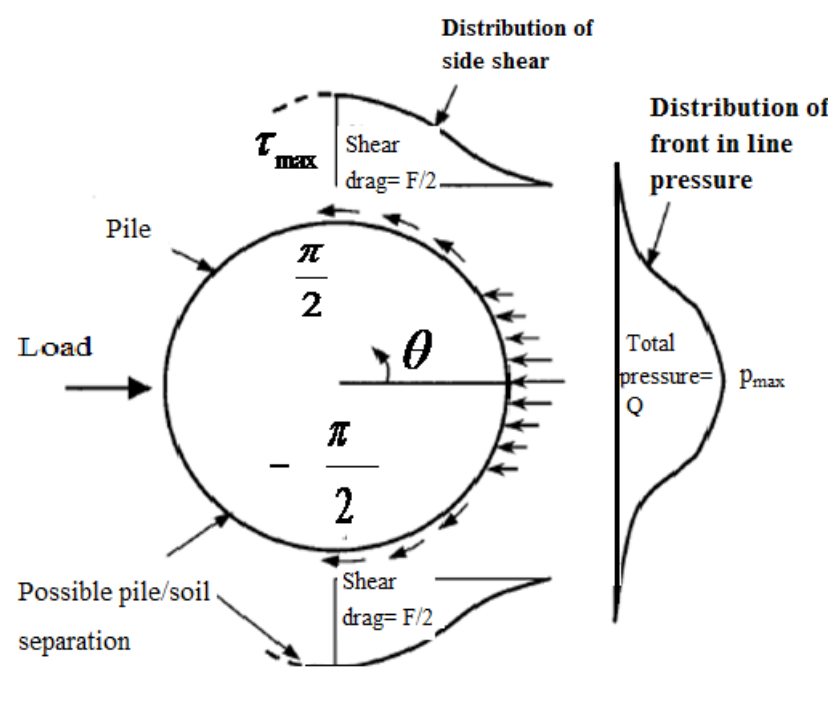
Fig. 2. Distribution of frontal soil resistance and side shear resistance in passive pile (Hassiotist et al.,